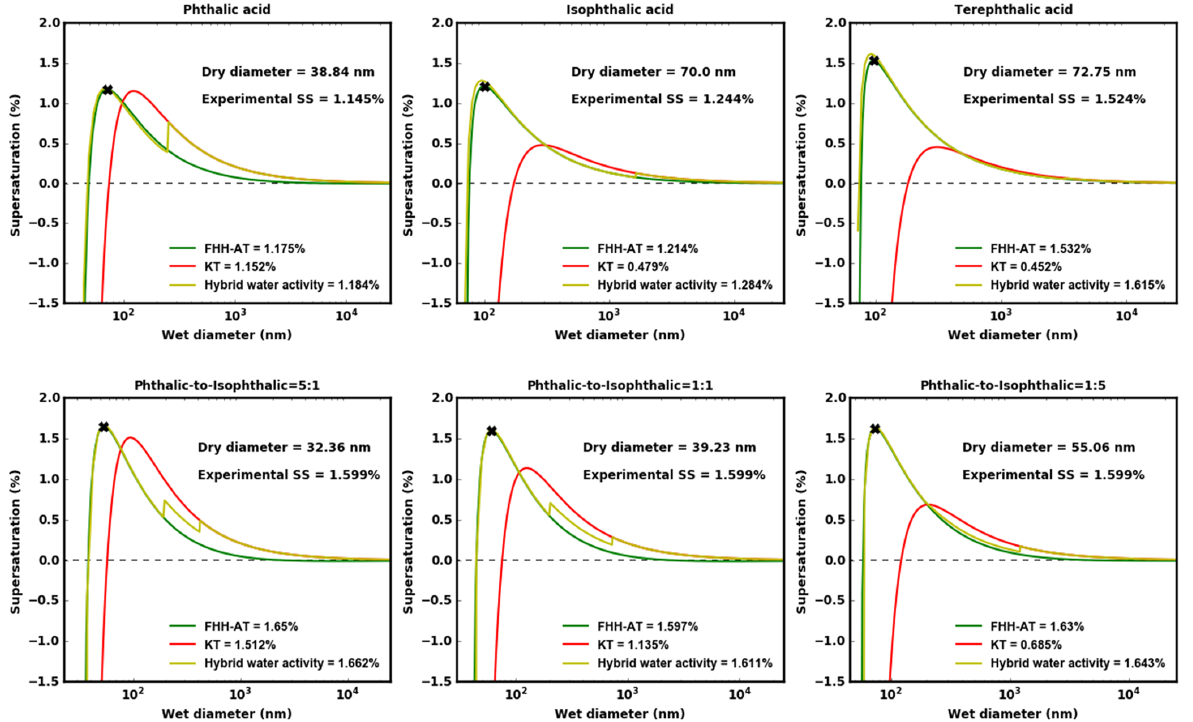
Figure 7. Equilibrium droplet growth curves for PTA, IPTA, TPTA and PTA–IPTA internal mixtures are shown here. The figure header shows the solute for which the respective equilibrium curves are plotted. KT, FHH-AT and HAM lines are shown in red (solid), green (solid) and yellow (solid), respectively. An exemplarily measured activation point for the respective solute is denoted using a solid red cross. The D dry , c and corresponding S used to generate these equilibrium curves are provided in Fig.